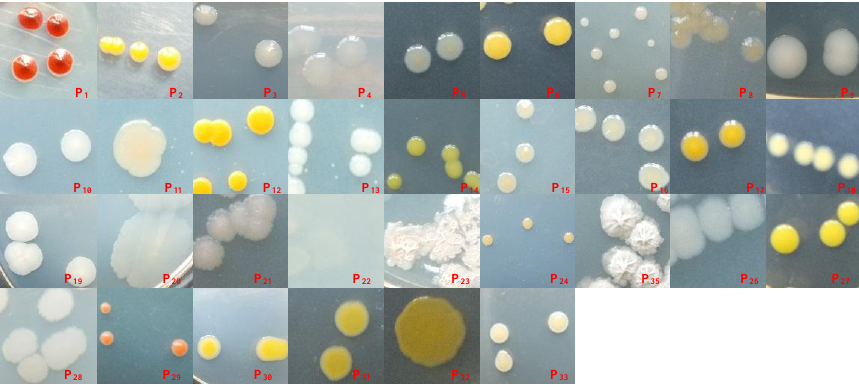
Figure 2. Photographs of colonies of 33 endophytic bacterial strains on Luria-Bertani medium plate.